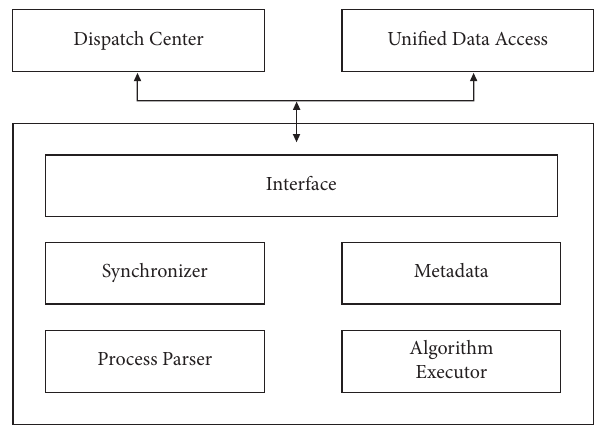
Figure 3: Calculation node module structure diagram.